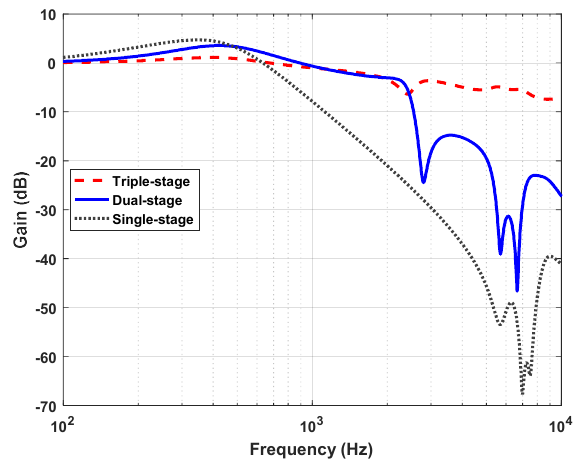
Figure 14. Sensitivity plot of different control schemes.